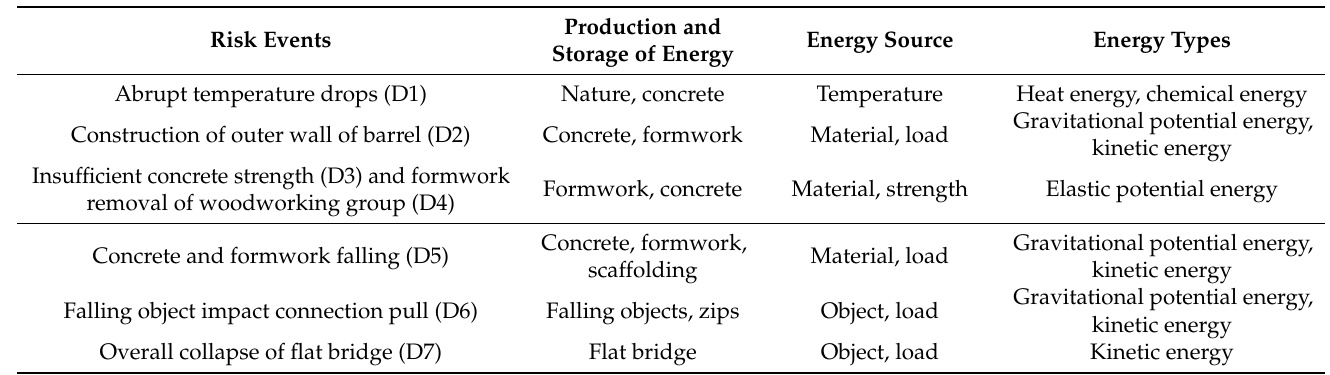
Table 3. Source and type discrimination of dangerous energy in construction.